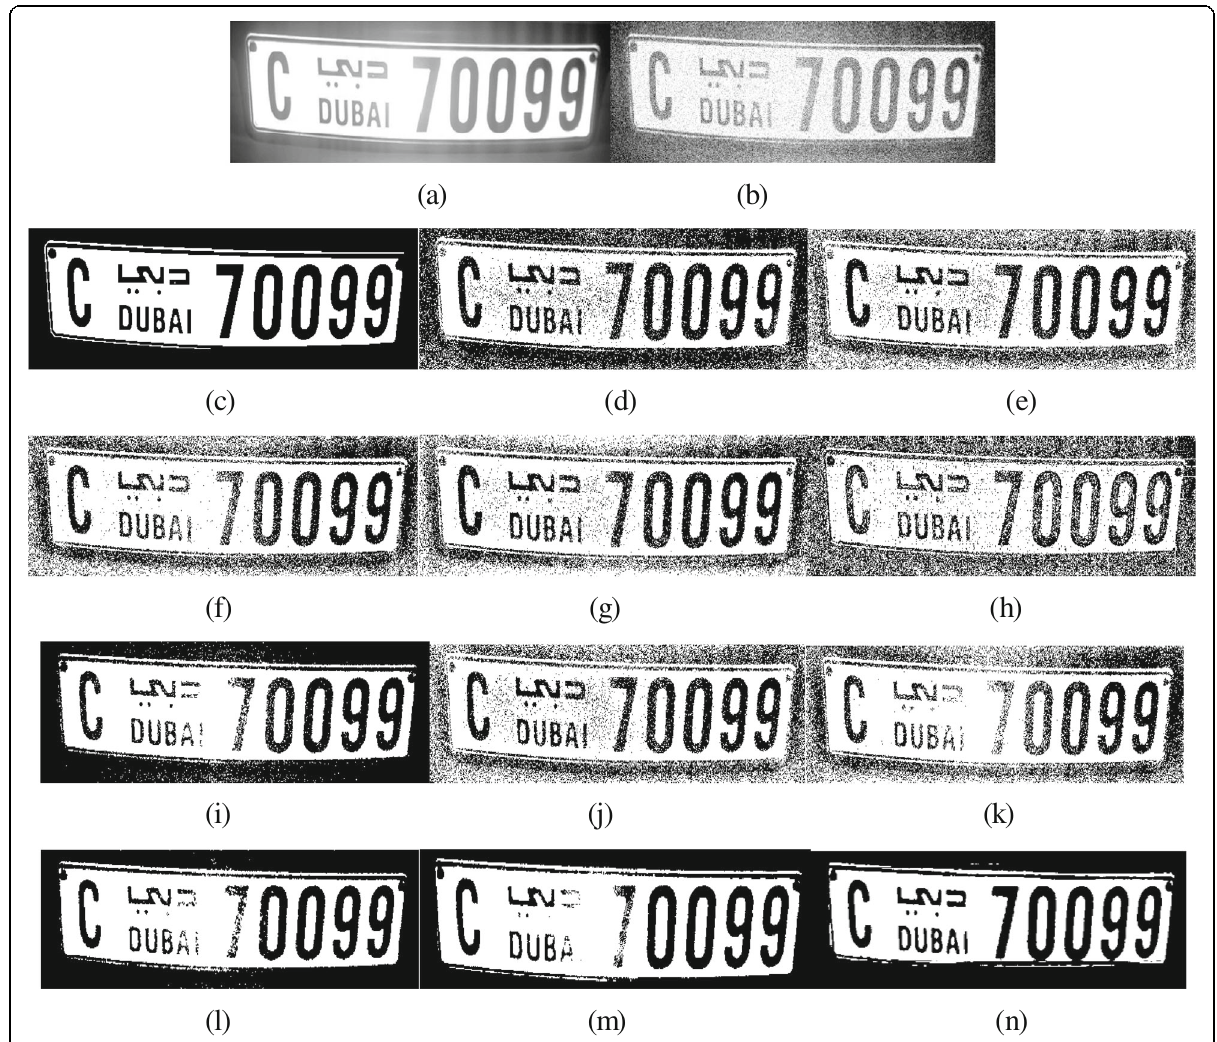
Fig. 12 Segmentation results on the license-plate image 153 × 544 corrupted by the Gaussian noise (0, 0.015). a Original image. b Noisy image. c Ground-truth. d Bernsen ’ s method. e Niblack ’ s method. f Sauvola ’ s method. g Bradley ’ s method. h Chou ’ s method. i Valizadeh ’ s method. j Wei ’ s method. k 2DOtsu. l FCM_NLS. m 2DWFPE. n Our method with T = 800, α =